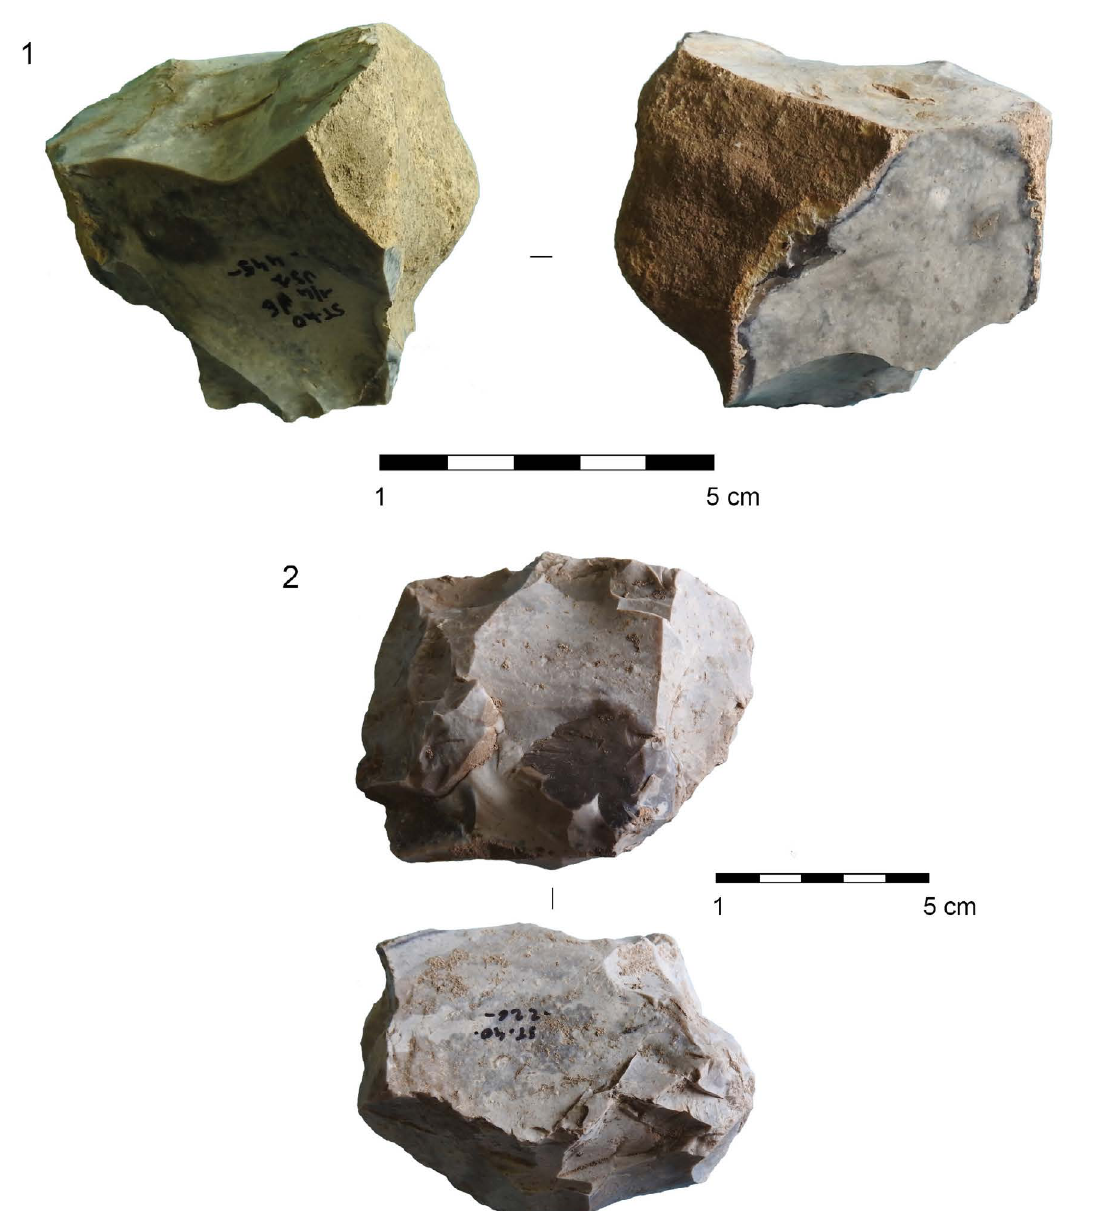
Figure 3. Exemples archéologiques de nucléus du site de Porte-Joie. 1, « La Couture aux Rois-zone C » (Eure). 1, exploitation des surfaces naturelles. 2, Exploitation unipolaire. Photos de É. Ravon. Figure 3. Examples of archaeological cores from Porte-Joie site. 1, exploitation of natural surfaces. 2, bipolar exploitation. Photos by É.